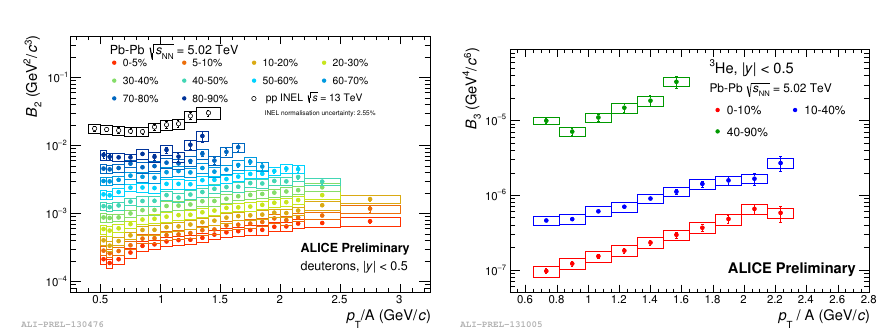
Figure 2. Coalescence parameters of deuterons ( B 2 , left panel) and 3 He ( B 3 , right panel) measured in Pb–Pb collisions at √ s NN = 5 . 02 TeV. The B 2 measured in pp collisions at √ s = 13 TeV is also shown in the left panel. Statistical uncertainties are represented as vertical bars whereas boxes represent the systematic ones. The ALICE preliminary proton p T -production spectra [6] are used to compute the coalescence